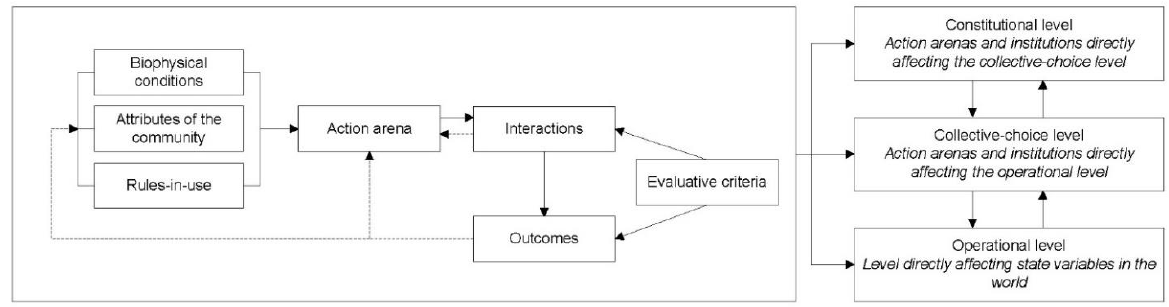
Fig. A1.1. The Institutional Analysis and Development framework. Source: modified from McGinnis